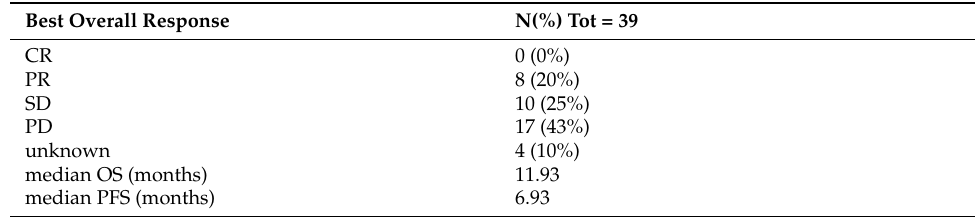
Table 2. Patients’ Outcomes.